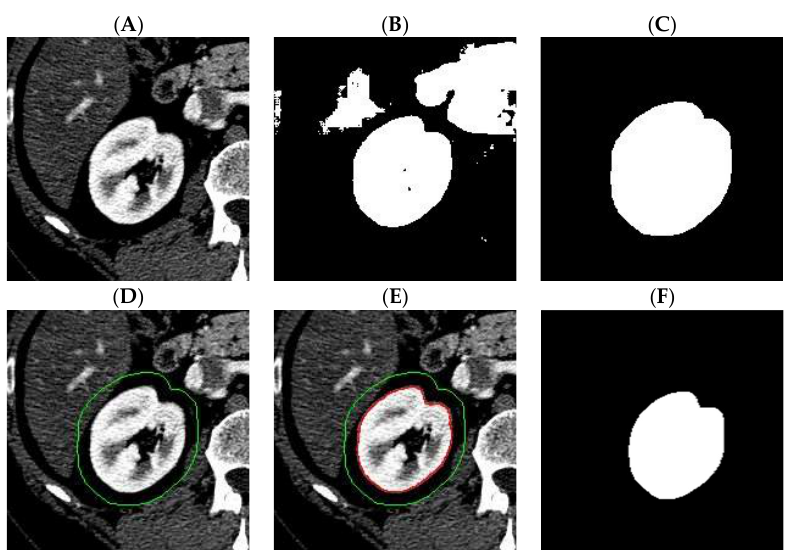
Figure 7. Visualization of the results in individual steps of the algorithm. ( A ): Raw image, ( B ): Image after applying U-Net without morphological transformations, ( C ): Image after initial morphological transformations (progression, holes filling), ( D ): Original image with starting search area ( 𝑆𝑚 ), ( E ): Image after applying extended maxima transformation (red border), ( F ): Reference mask manually generated by a human expert.